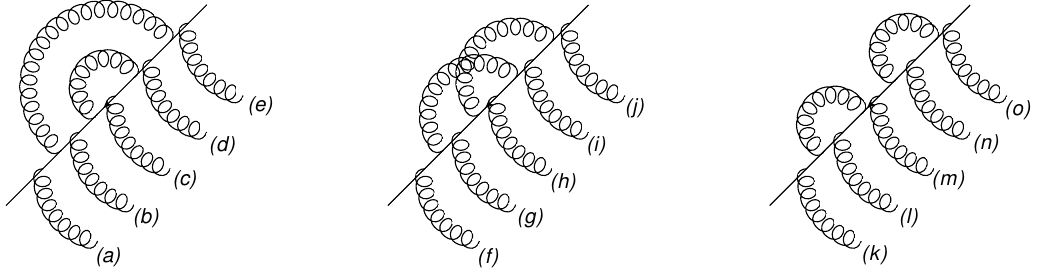
Figure 10 . The (5,1) web in a compact representation. Note that in any given diagram in this web there is just one non-boomerang emission. Labels attached to the gluons correspond to the diagram obtained by placing the gluon as shown, and connecting it with a second Wilson